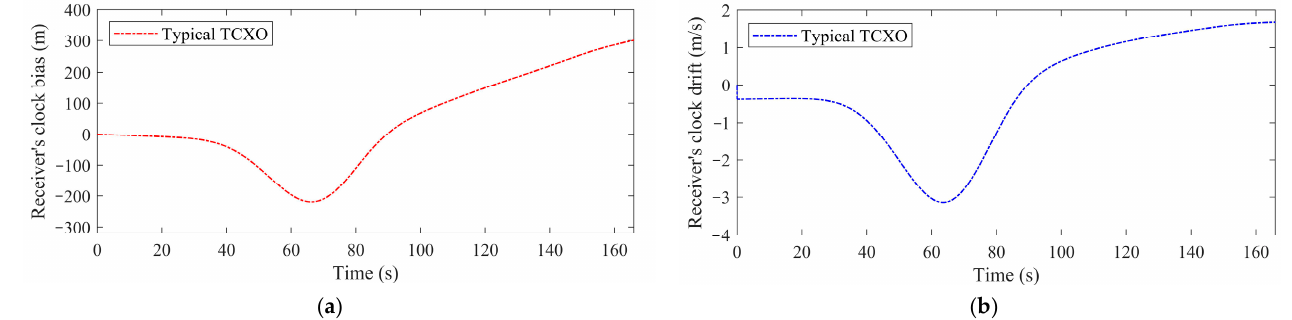
Figure 13. ( a ) The estimated receiver’s clock bias. ( b ) The estimated receiver’s clock drift.